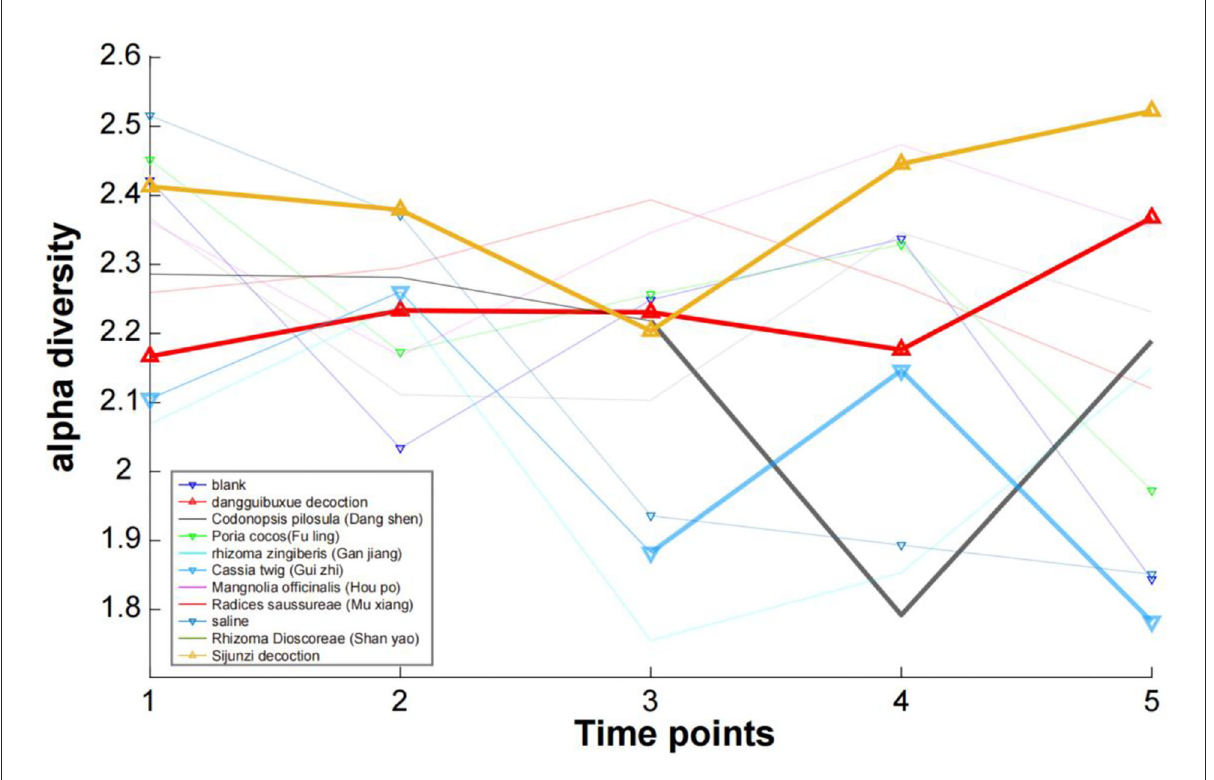
FIGURE6 The alpha diversity Shannon index for each sample of each